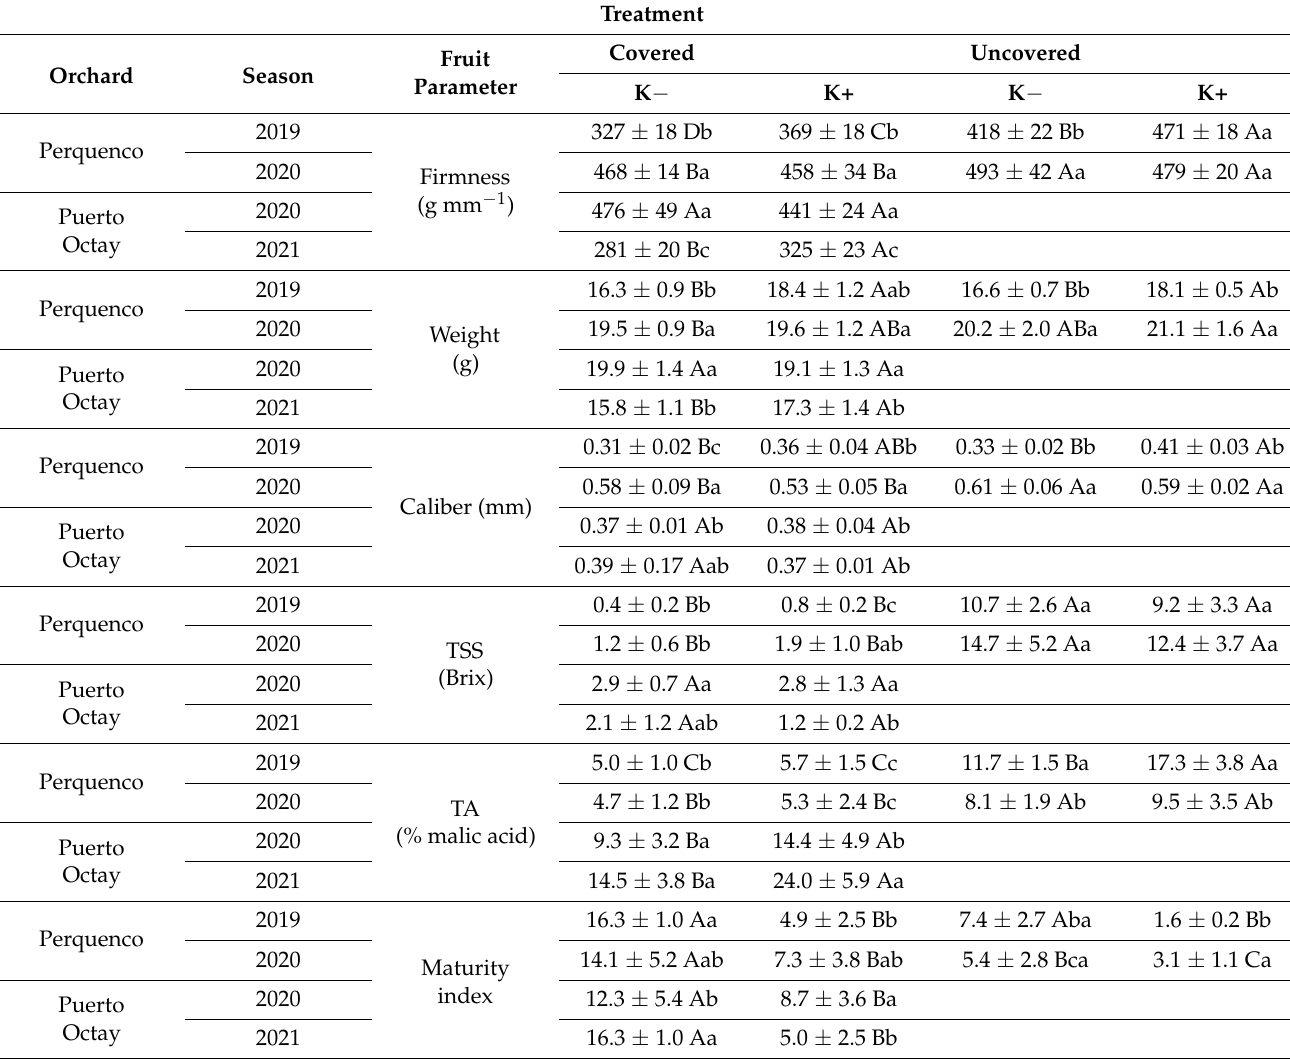
For each parameter, average values ± standard deviation are presented. Statistically significant differences between treatments for each season and orchard are represented by different uppercase letters (horizontally). Differences between season and orchard, for each K treatment, are represented by vertical lowercase letters based on the LSD Fisher multiple range test ( p ≤